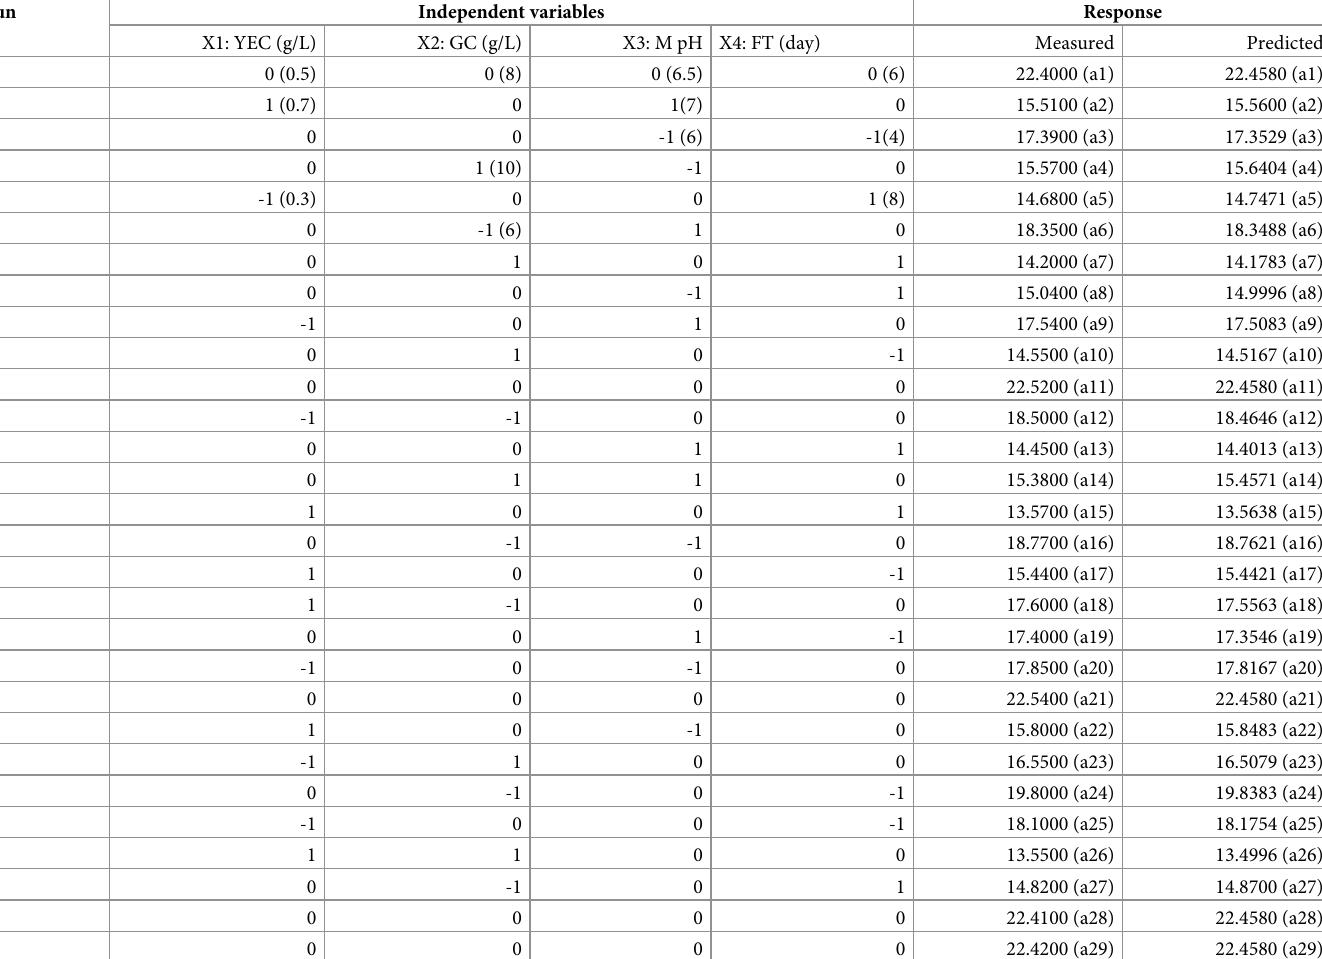
Table 4. Experimental design and results of the Box-Behnken design for the optimization of the antibacterial activity of the fungal isolate Colletotrichum alatae